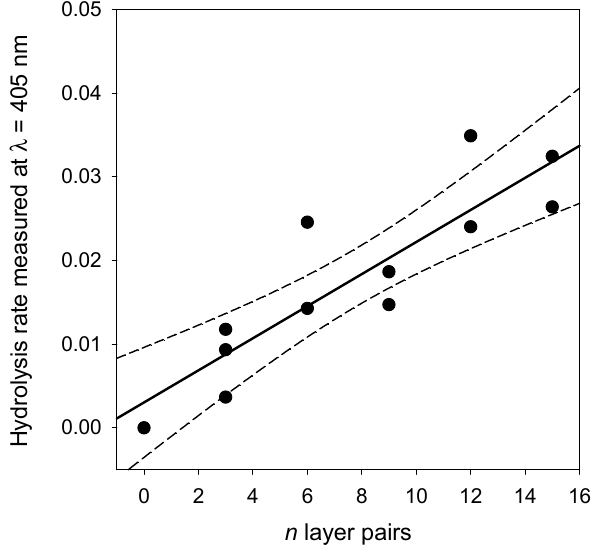
Figure 11. Evolution of the hydrolysis rate of (PAH-PDA@ALP) n films as a function of the number of deposited layer pairs. The solid line corresponds to a linear regression of the data points, whereas the dashed lines correspond to the limit of the 95% confidence interval.